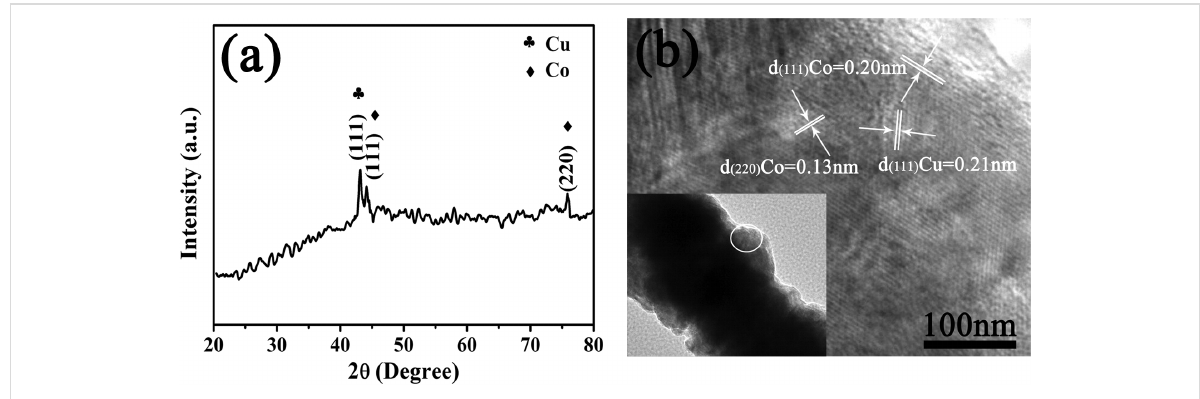
Figure 3: (a) XRD pattern and (b) HRTEM pattern of bimetallic Co–Cu nanowires.